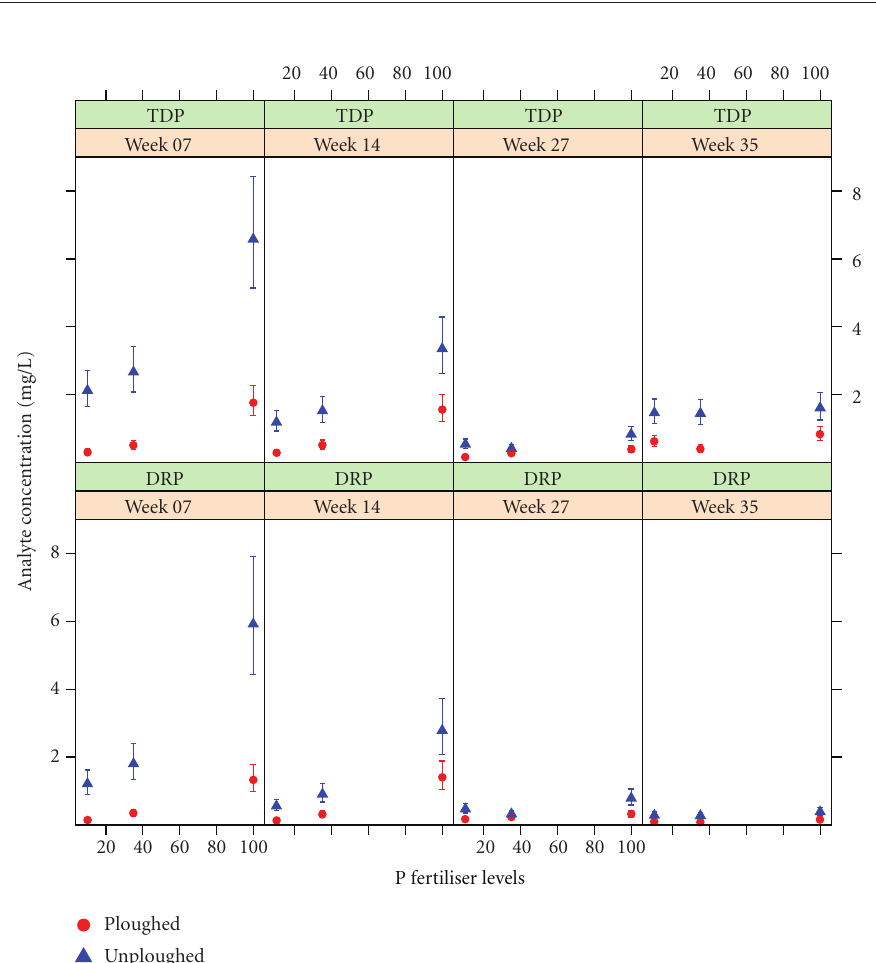
Figure 3: Mean TDP and DRP concentrations in soil water for ploughed and unploughed treatments at di ff erent P fertiliser levels showing the decay over the trial period. Week represents the number of weeks since fertiliser treatments began. Error bars represent significance at 5%